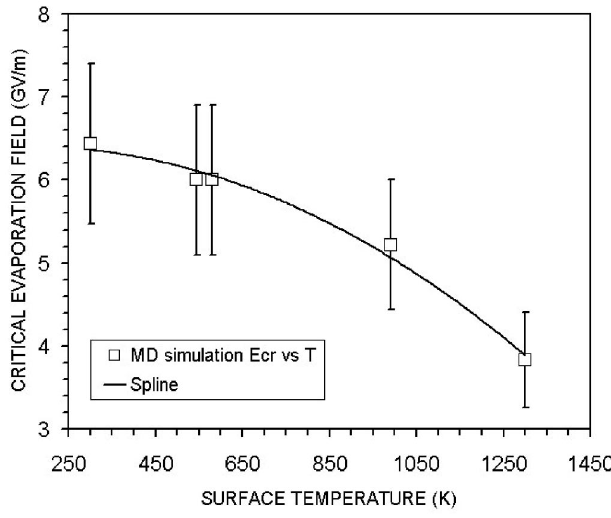
FIG. 2. Observed temperature dependence of critical evapora- tion field for removing cluster of (cid:4) 200 Cu ions.